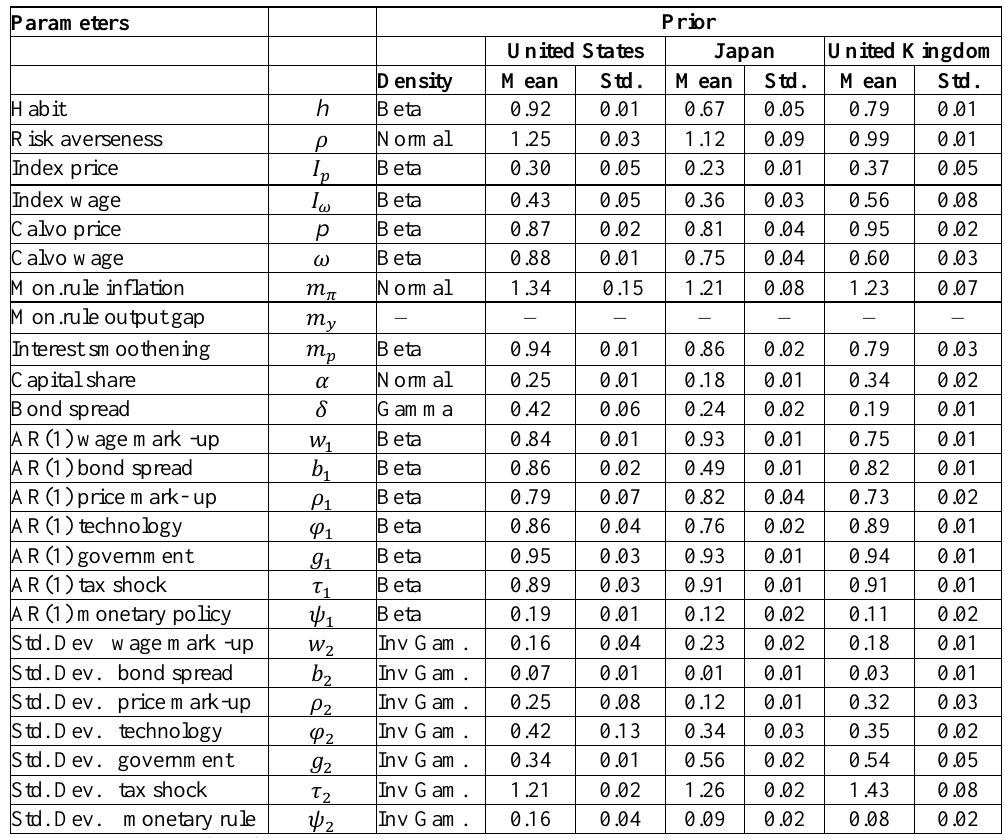
Table 3. Posterior Estimation of the Optimal Calibrated Scenario (S High Fiscal Policy